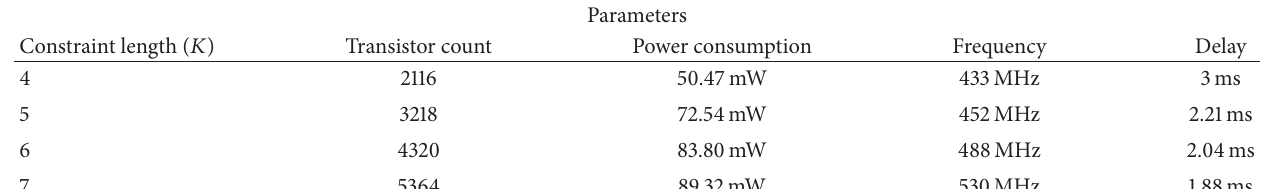
Table 2: Comparison of parameters of asynchronous Viterbi decoder for various constraint lengths.